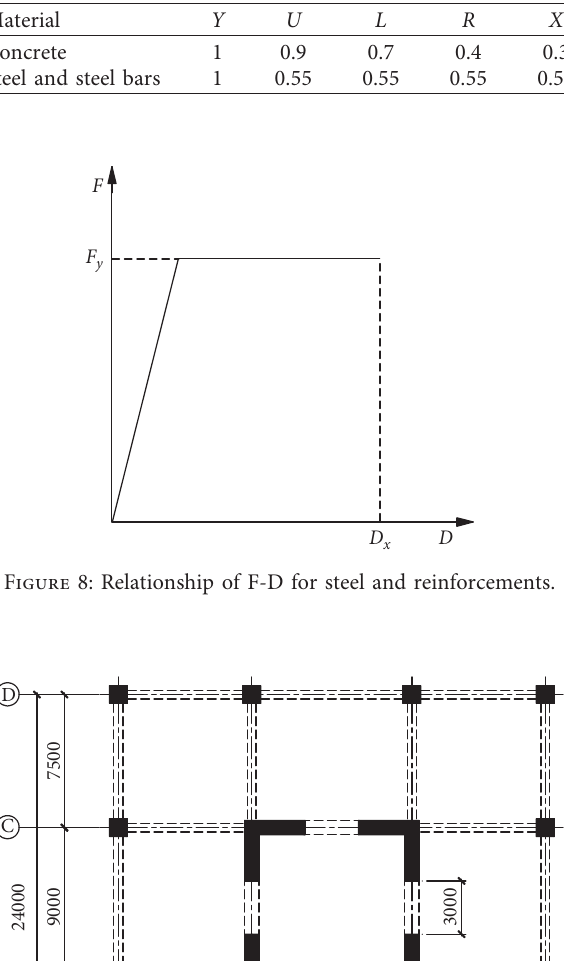
Table 1: Strength degradation coefficient of materials.